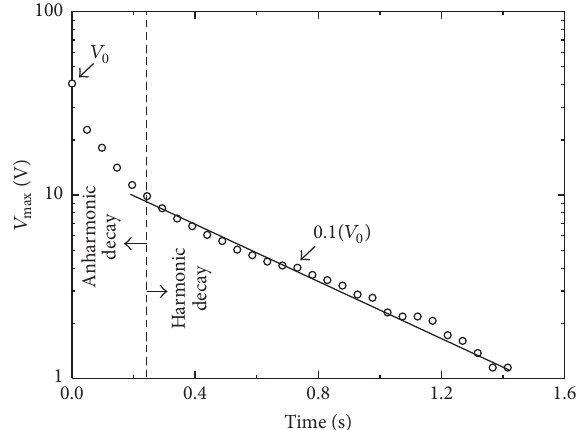
Figure 4: Decay curve of the voltage signal produced by the PZT energy